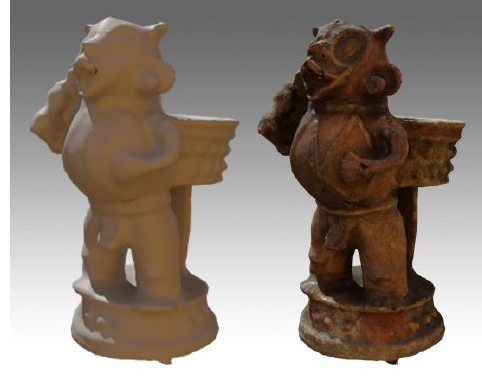
Figure 19. Raw and textured